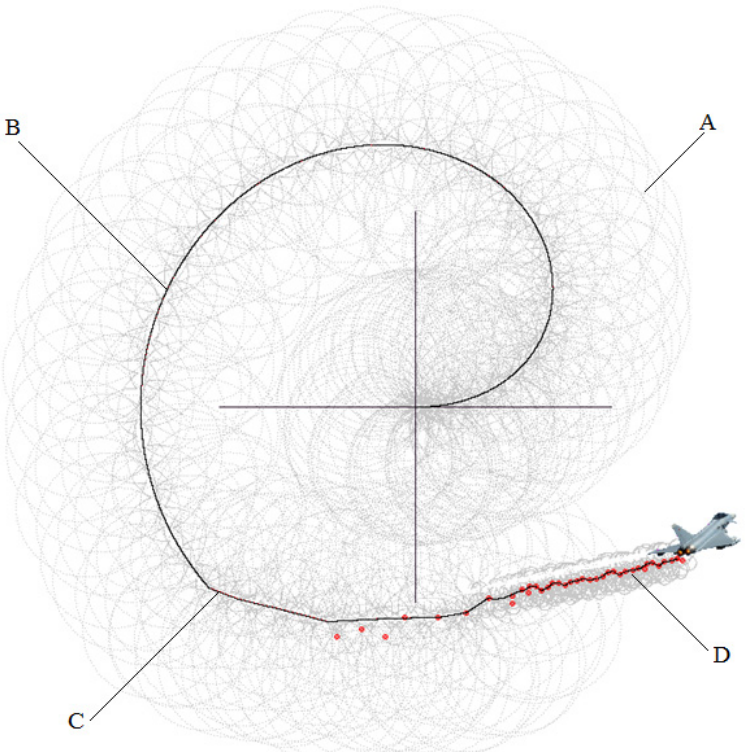
Figure 12. The process of modified LQR control of the seeker axis in the airspace search phase and in the phase of tracking a detected target. Description of the markings used in Figures 12–14: